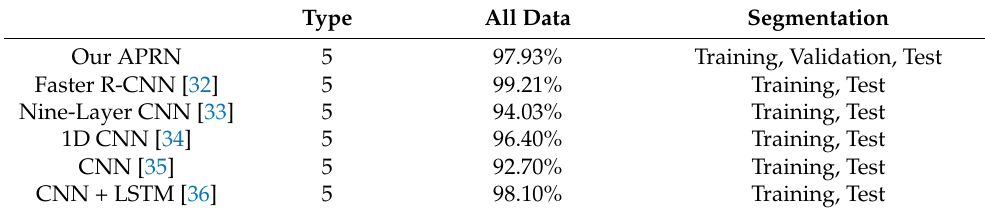
Table 7. Test set accuracy of each network under the MIT-BIH database.